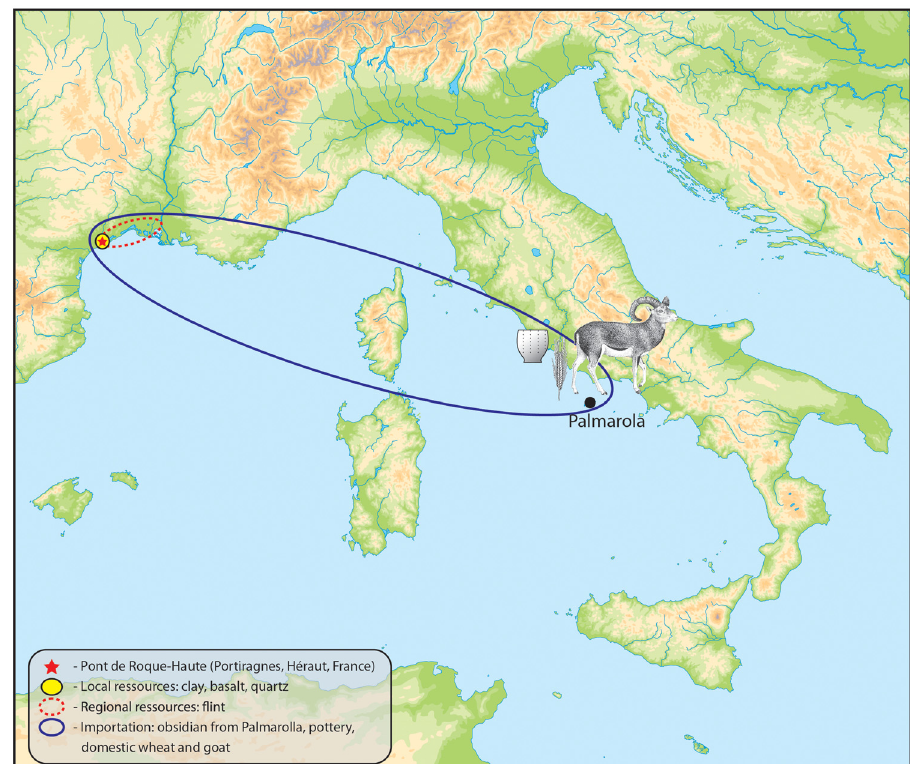
Figure 4: Schematic map of the extension of exogeneous raw material provenance in the Early Neolithic ( Impressa ) site of Pont de Roque - Haute ( Hérault, France ) ( after Guilaine et al., 2007 )